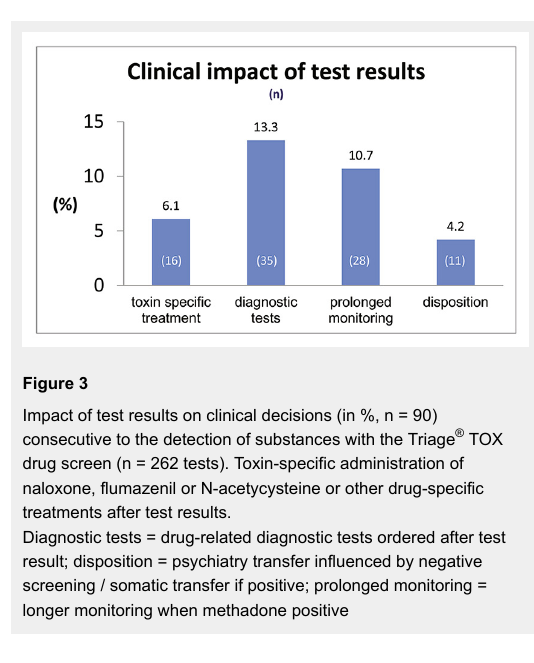
Indications for urinary drug screening (n = 369) in 262 patients. Arrhythmia or long QT = QT prolongation >480 ms, or ventricular tachycardia or flutter, or torsade de pointes tachycardia; Hypotension = systolic hypotension (<80 mm Hg); Opiate toxidrome = if requiring antagonist administration; Psychosis = first psychotic episode; Resp failure = acute respiratory failure (pCO 2 45-80 mm Hg or emergency intubation); Sympathomimetic = clinical signs of sympathomimetic toxicity